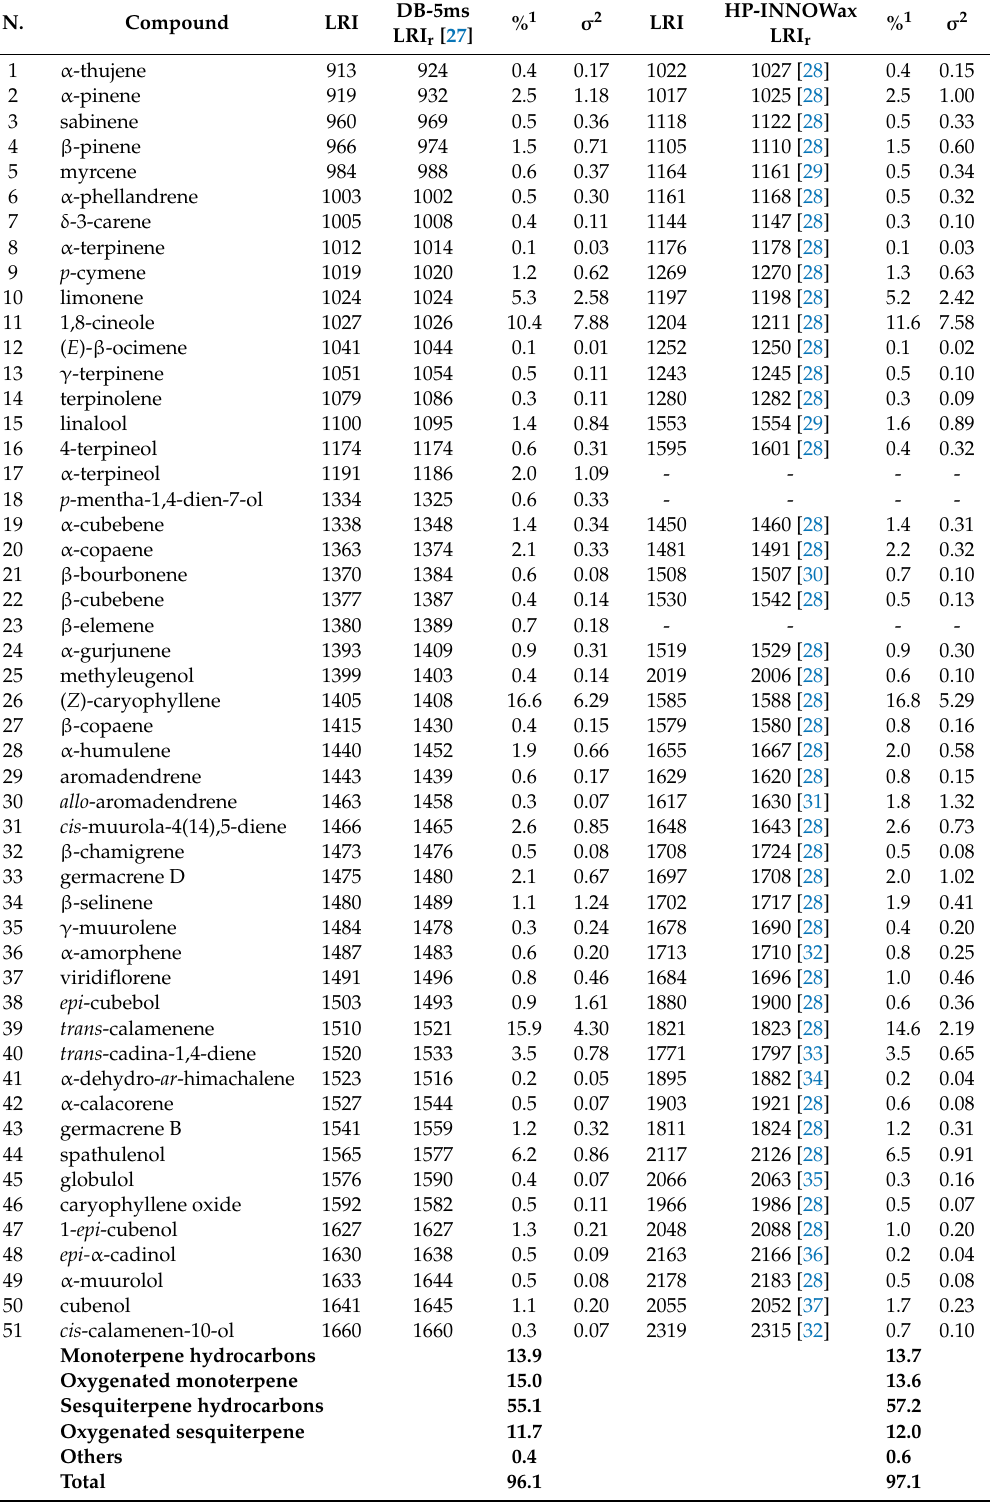
Table 1. Chemical composition of the essential oil of M. myrsinoides in DB-5ms and HP-INNOWax columns.